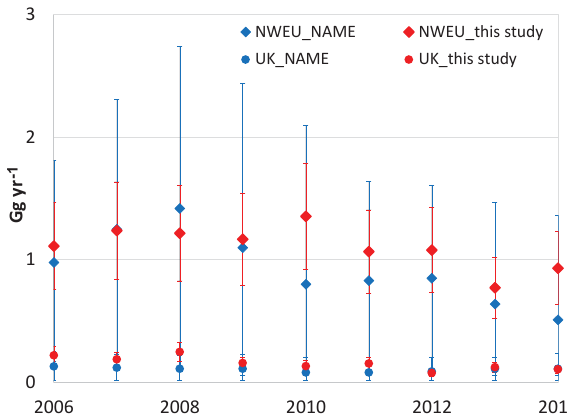
Figure 7. Comparison between emissions from the UK (circles) and the NWEU domain (diamonds) estimated through the NAME (blue) and the Bayesian (red)